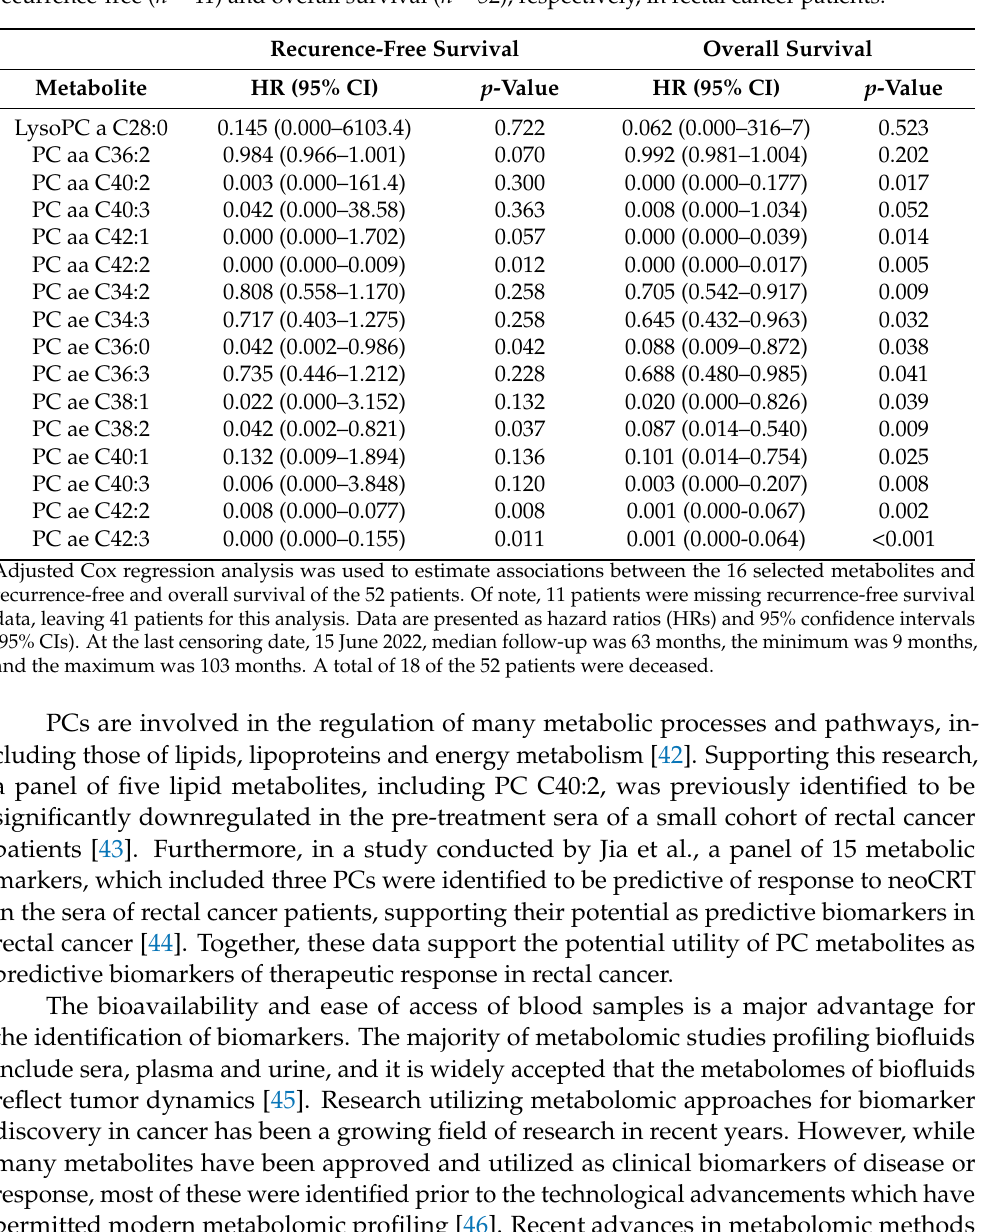
recurrence-free ( n = 41) and overall survival ( n = 52), respectively, in rectal cancer